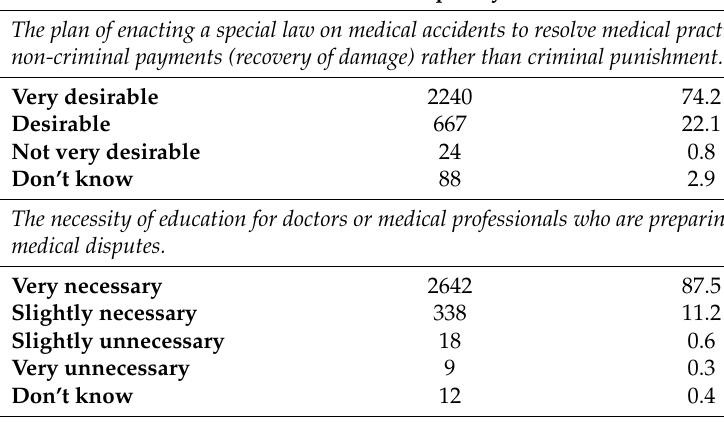
Table 5. The necessity of education and an institution for medical disputes. Frequency